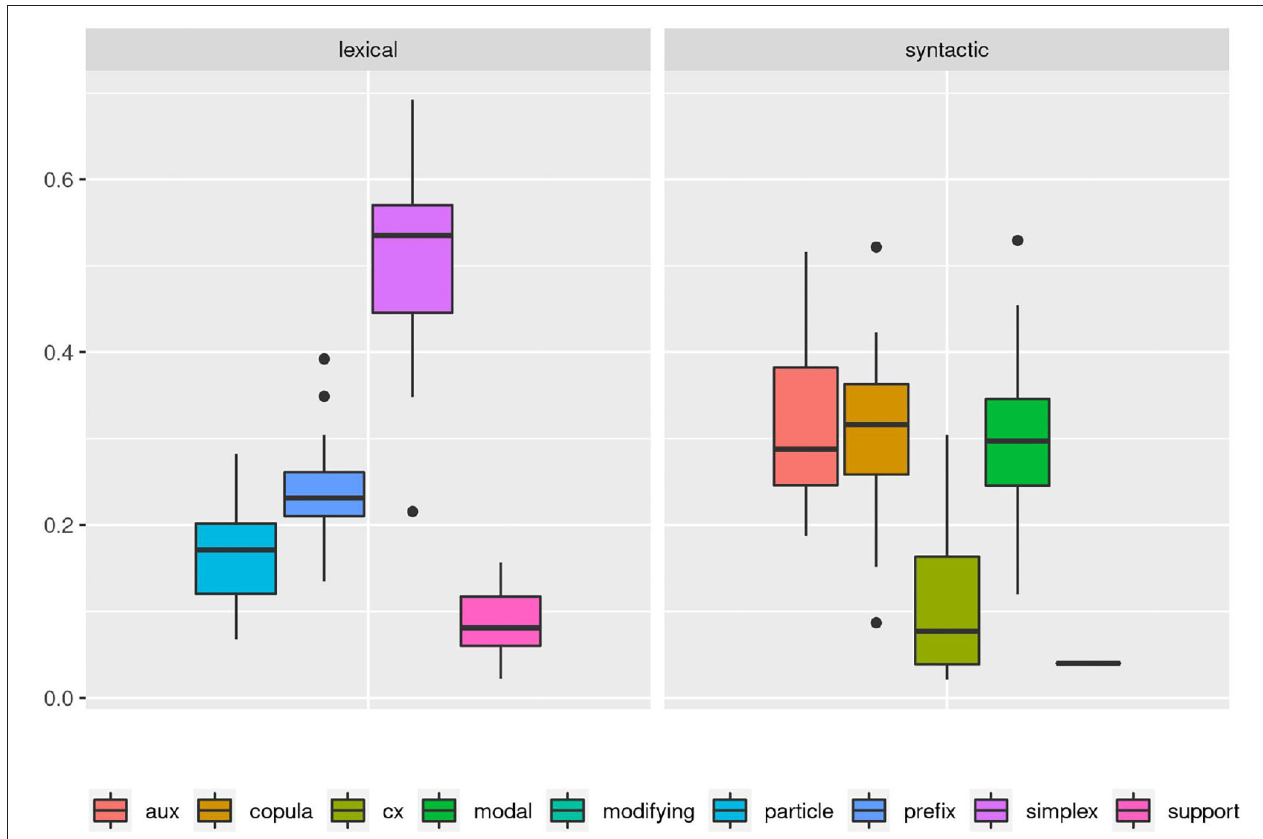
FIGURE 2 | A boxplot based on the proportion of each verb subclass as it is found in the individual documents of the corpus shows a more complex picture. Long whiskers indicate considerable overlap between all syntactic verb subclasses. Similarly, the non-simplex lexical verb subclasses all partially overlap and even the clear dominance of simplex verbs among the lexical verbs is called into question with several outliers overlapping between prefix and simplex